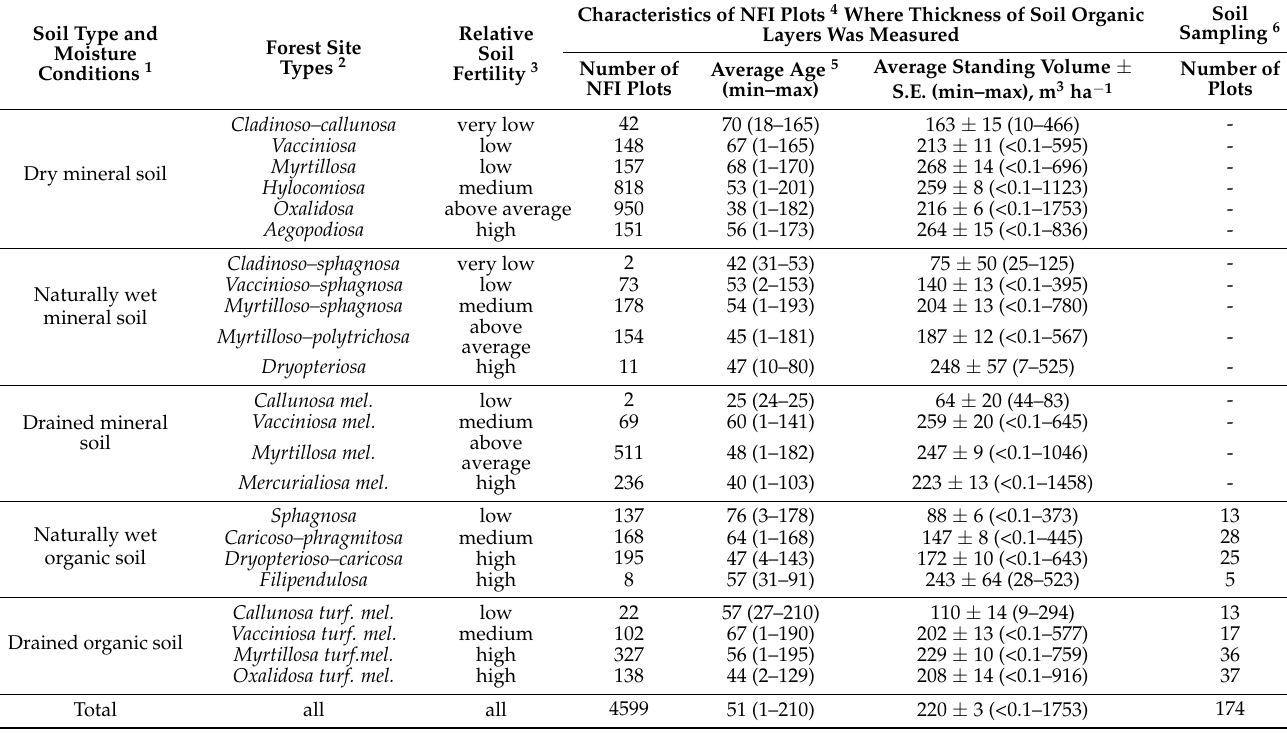
Table 1. Characteristics of plots in forest land where soil organic layer thickness was measured (NFI plots) and soil was sampled for physico-chemical